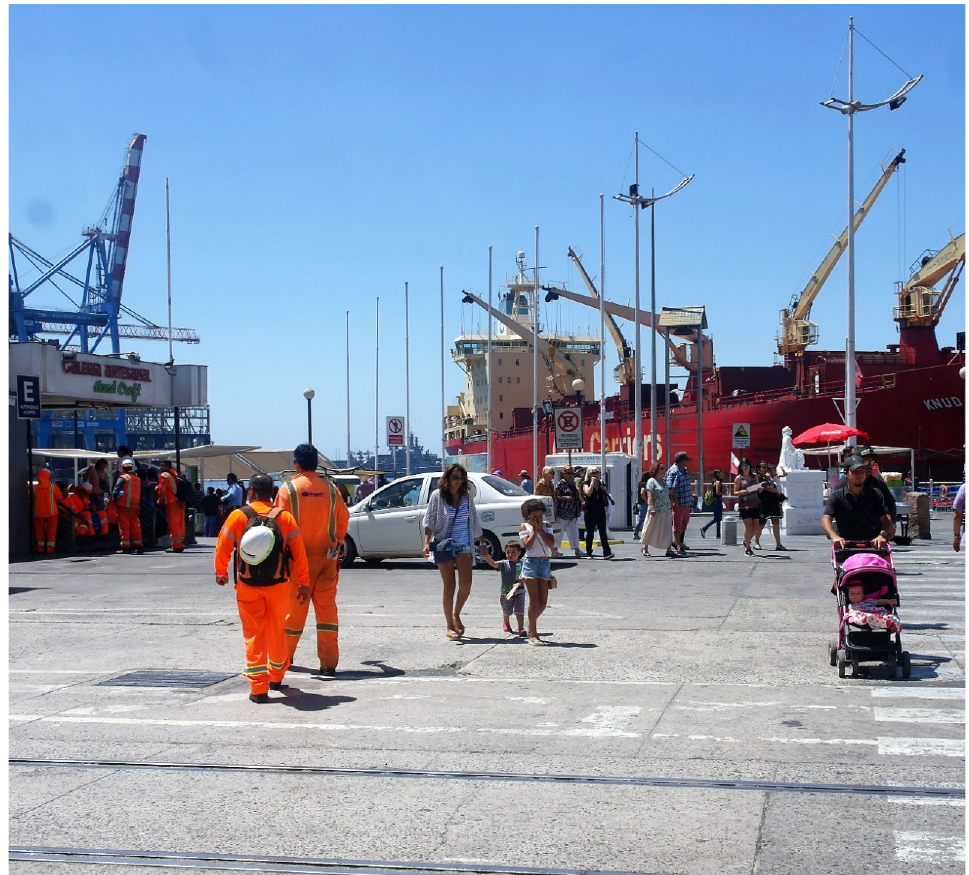
Figure 6. Dockworkers and visitors in front of the TPS Gate and pedestrian crossing near the Prat Pier. Source: Hernán Cuevas (photograph taken circa